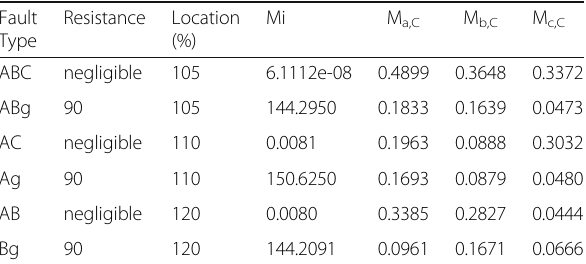
Table 5 Results of fault locations more than